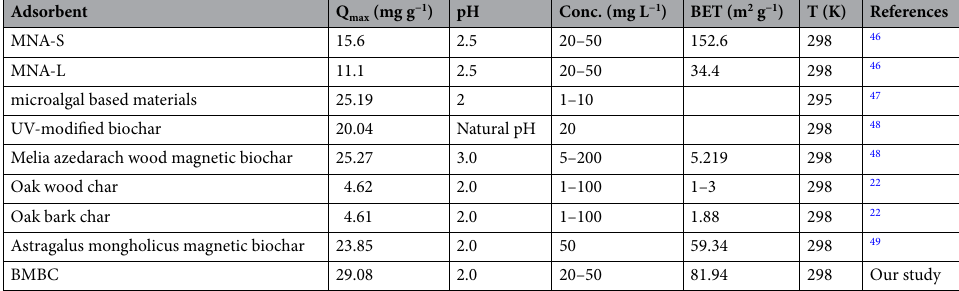
Table 3. The Q max of BMBC evaluated by Langmuir model comparison with other similar adsorbents for Cr(VI) adsorption.